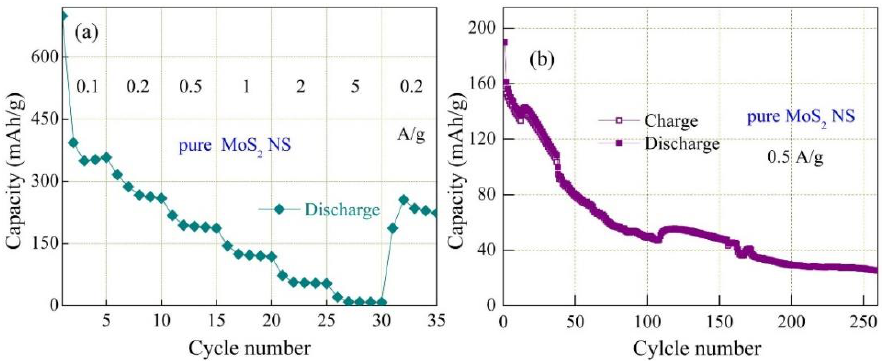
Figure 4. ( a ) The rate performance data of pure MoS 2 NS in range of 0.1 – 5 A g −1 . ( b ) The cycling stability data of pure MoS 2 NS at 0.5 A g −1 .